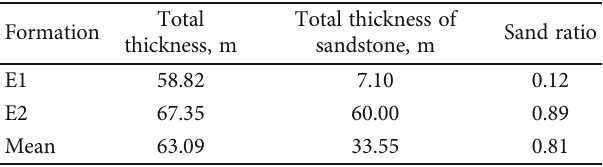
Table 7: Statistical table of sand-to-ground ratio parameters of Yingmai 7